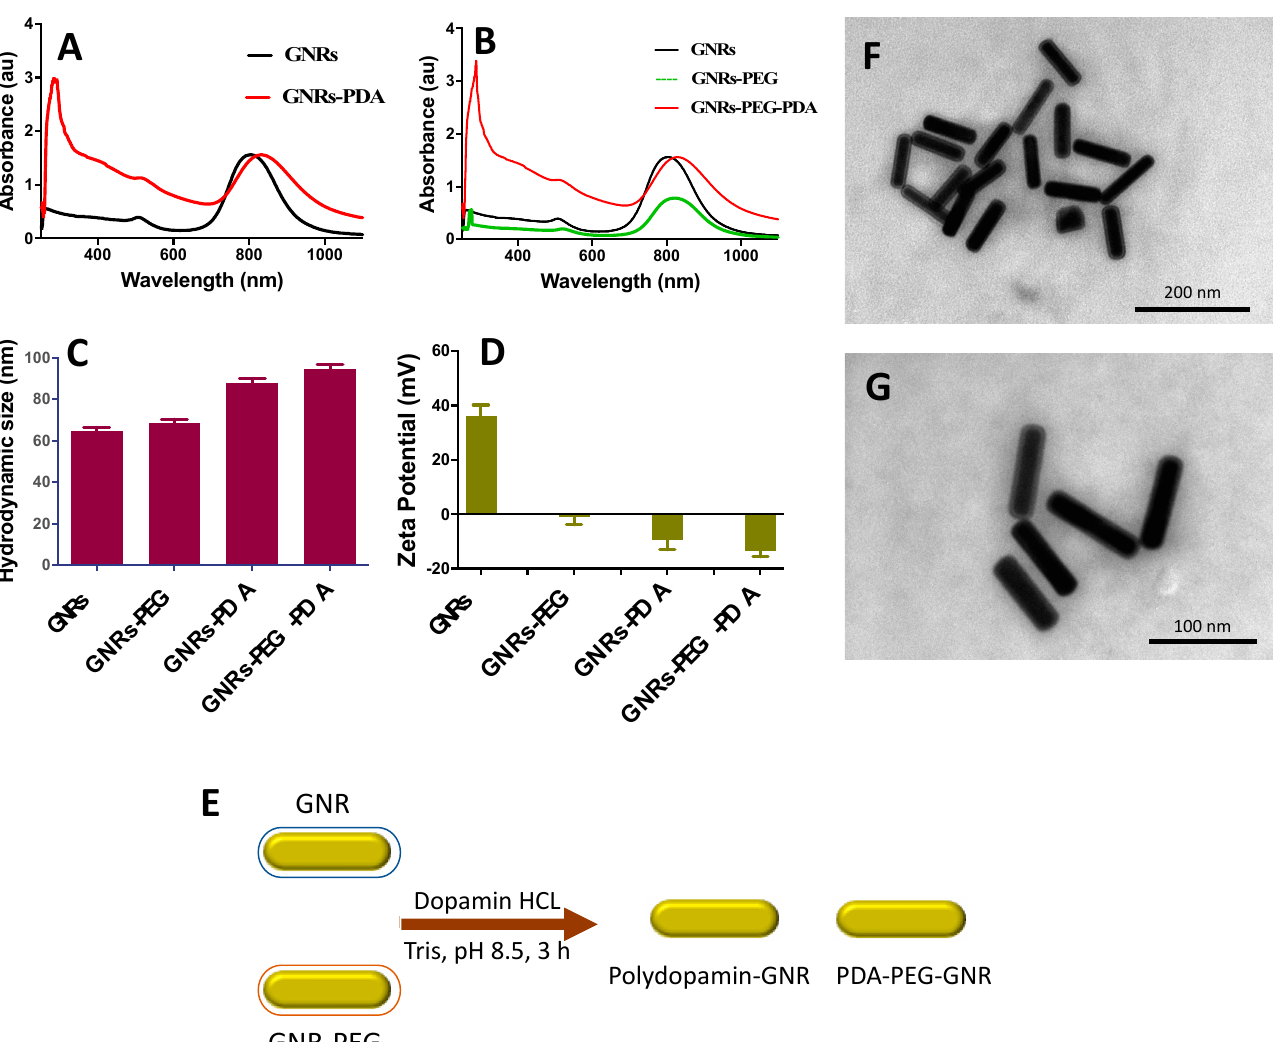
Figure 1. ( A ) UV-Vis absorption spectra of GNRs and GNRs-PDA. ( B ) UV-Vis absorption spectra of GNRs, GNRs-PEG Figure 1. A ) UV-Vis absorption spectra of GNRs and GNRs-PDA. B ) UV-Vis absorption spectra of GNRs, GNRs-PEG and and GNRs-PEG-PDA. ( C ) Hydrodynamic sizes of GNRs, GNRs-PEG, GNRs-PDA and GNRs-PEG-PDA. ( D ) Zeta potential GNRs-PEG-PDA. C ) Hydrodynamic sizes of GNRs, GNRs-PEG, GNRs-PDA and GNRs-PEG-PDA. D ) Zeta potential val- values of GNRs, GNRs-PEG, GNRs-PDA and GNRs-PEG-PDA. ( E ) A Scheme demonstrated briefly the preparation of ues of GNRs, GNRs-PEG, GNRs-PDA and GNRs-PEG-PDA. E ) A Scheme demonstrated briefly the preparation of PDA- PDA-conjugated GNR. ( F & G ) TEM images of GNRs-PEG-PDA revealed an average length and width of 77.5 nm ± 5.5 nm and 19.4 nm ± 6.2 nm, respectively, and an average aspect ratio (AR) ~4. The thickness of the PDA layer around the nanoparticles is estimated to be ~6.1 nm ± 1.4